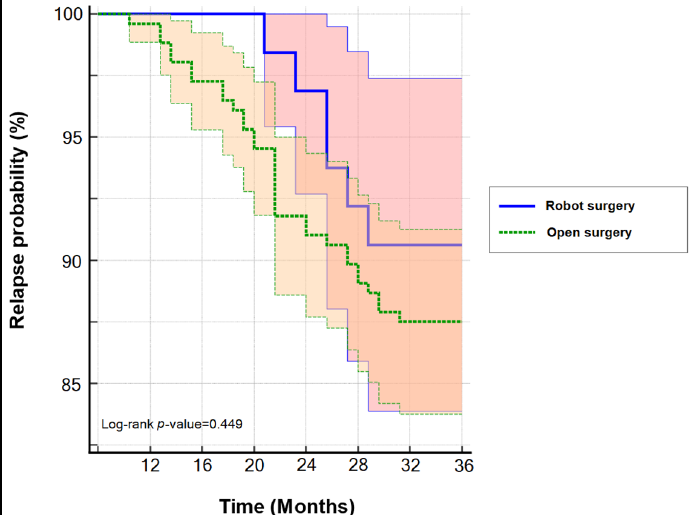
Figure 1. Kaplan–Meyer plot of the three-year disease-free survival in patients with early-stage cervical cancer based on the surgical treatment type.